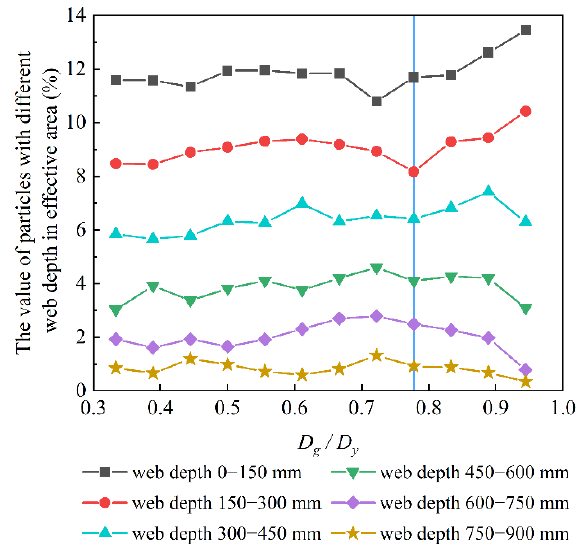
Figure 19. The effect of barrel diameter on conveying performance of particles with different web depths in pushing mode ( D y = 900 mm).